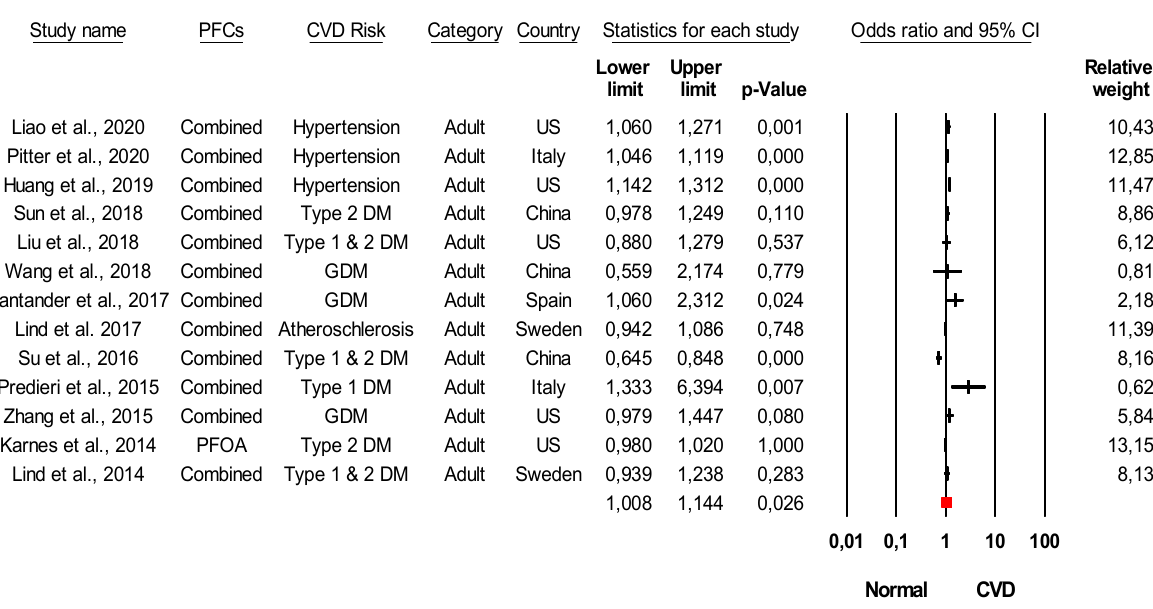
Figure 3. Association of PFCs exposure with their risk factors. Meta-analysis using random-effects model, ordered by date of publication. PFCs combined = combination of more than 2 PFCs. GDM = gestational diabetes mellitus, DM = diabetes mellitus. Test for overall effect: z = 4.03, p < 0.0001; Test for heterogeneity: I 2 = 85.8% Q = 84 df = 12, p < 0.0001.